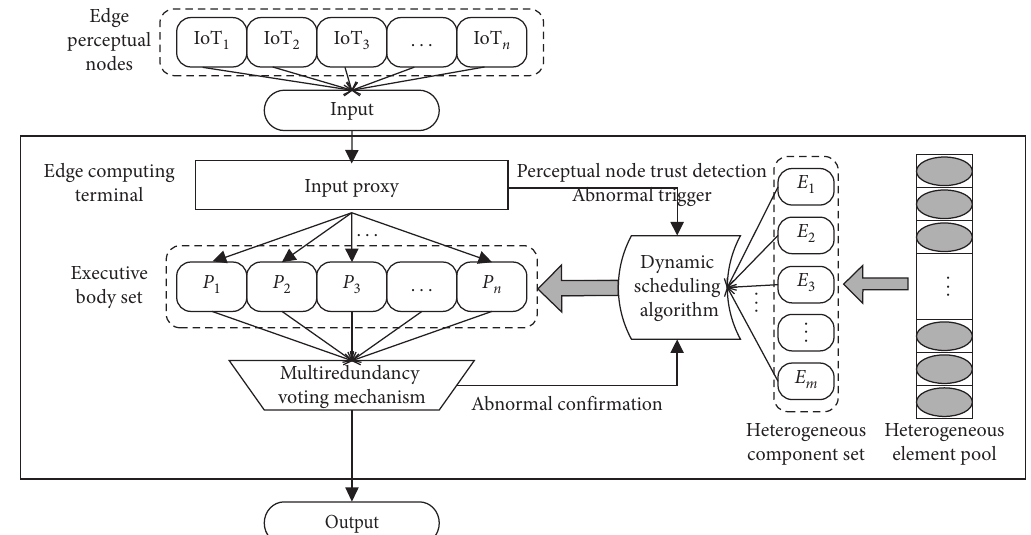
Figure 4: Dynamic multiredundancy mimic defence model.